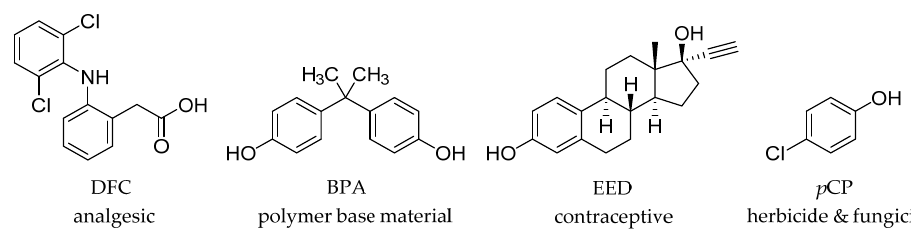
Figure 7. Organic trace pollutants used as model substances for degradation studies with F2.